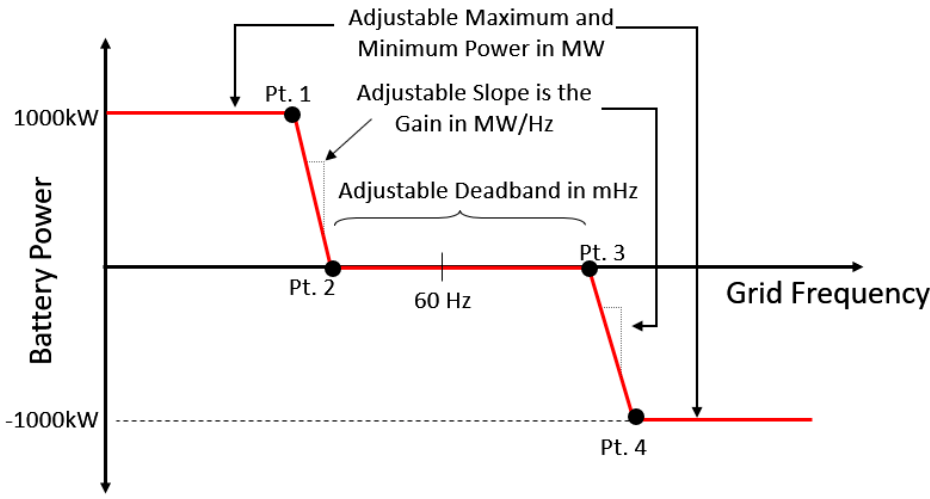
Figure 2. The frequency-Watt curve used to adjust the frequency response characteristics of the BESS.